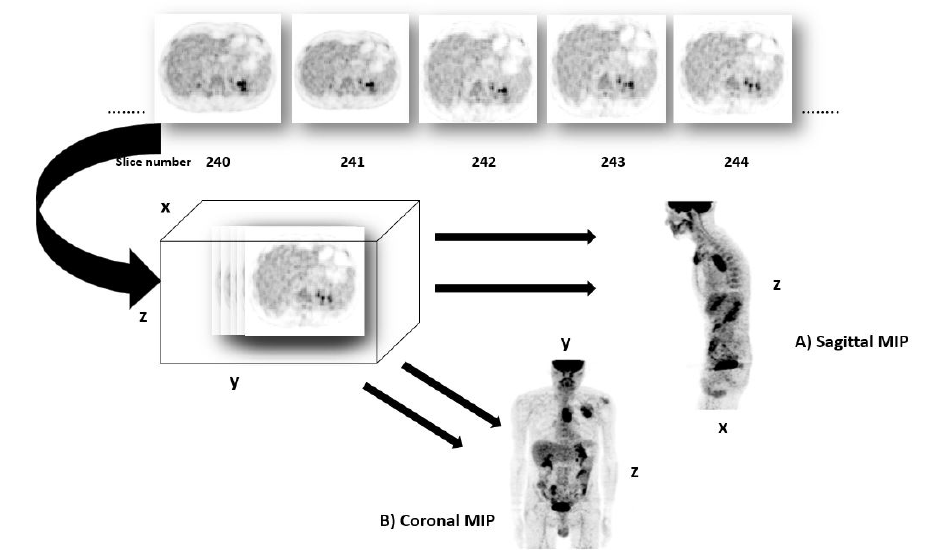
Figure 3. Maximum intensity projection (MIP) of a PET exam. ( A ) projection in Sagittal. ( B ) Projection in Coronal. The two MIPs in sagittal and coronal views allow providing a better context than one MIP view and to maintain a link to the x, y and z